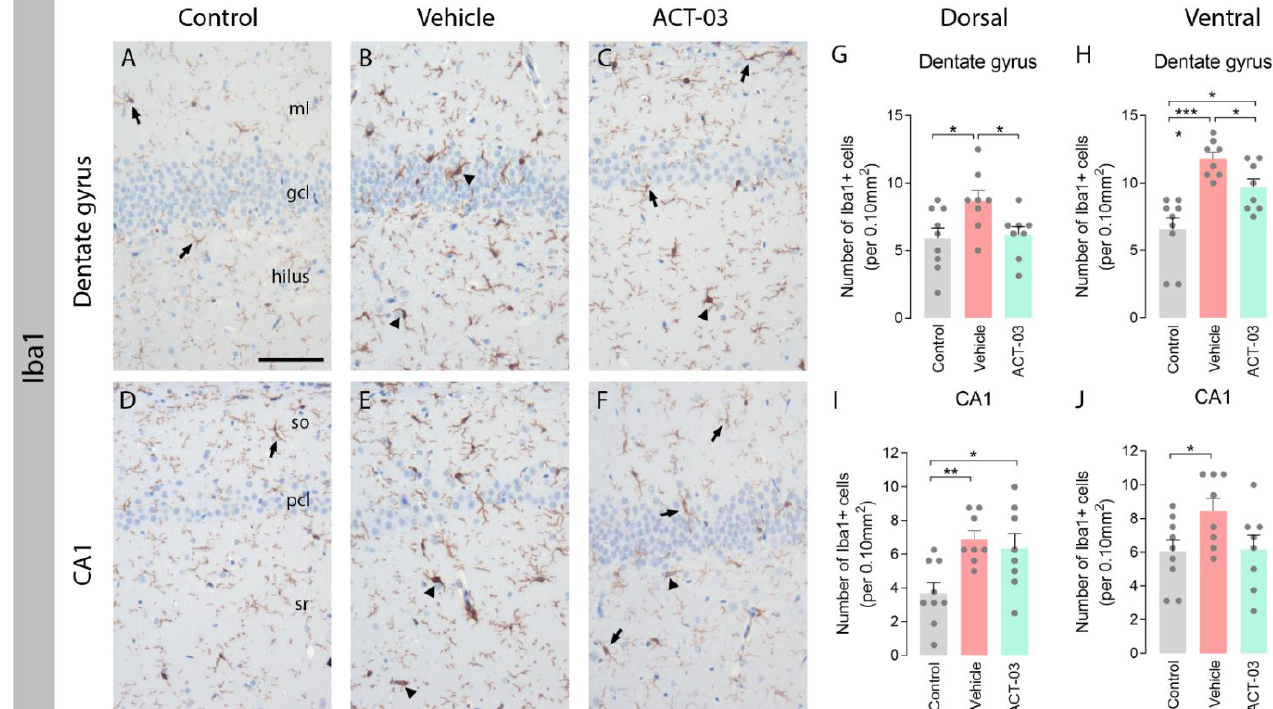
Figure 3. Increased microgliosis after kindling is ameliorated by ACT-03 treatment. ( A – F ) Iba1- positive microglia with a resting morphology (arrows) were observed in the hippocampus of non- kindled animals ( A , D ), where Iba1-positive microglia in kindled, vehicle-treated animals have thick and coarse processes (arrowheads). In kindled, ACT-03-treated animals, Iba1-positive microglia with both resting and active morphologies were observed ( C , F ). ( G – J ) Quantification shows a higher number of Iba1-positive microglia in kindled versus non-kindled animals in multiple regions ( p < 0.05). Iba1-positive cells was lower in the DG of the dorsal and ventral hippocampus of ACT-03-treated animals versus vehicle-treated animals. Scale bar in A for A–F; 100 µ m; hematoxylin counterstained; ml, molecular later; gcl, granular cell layer; so, stratum oriens; pcl, pyramidal cell layer; sr, stratum radiatum. Bar graphs display mean + SEM, with individual values as dots; *, p < 0.05; **, p < 0.01; ***, p <